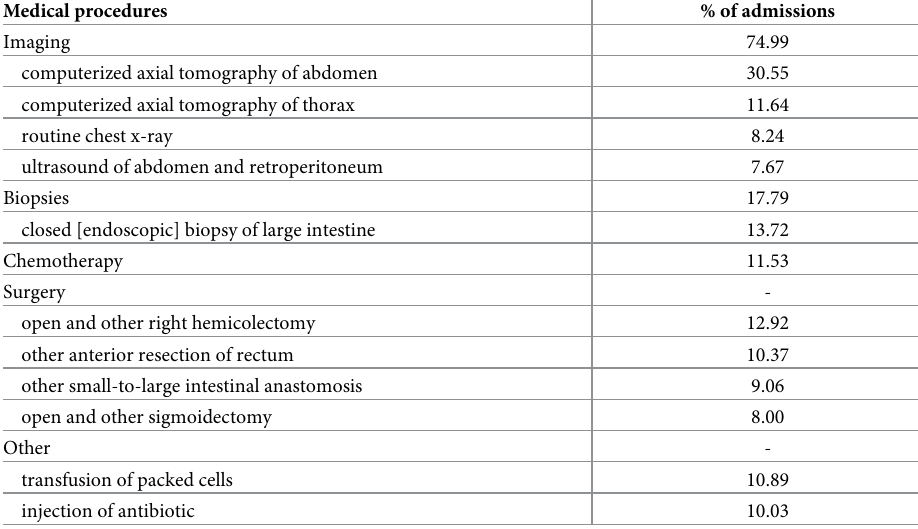
Table 5. Principal medical procedures performed in the course of the hospital admission. Medical